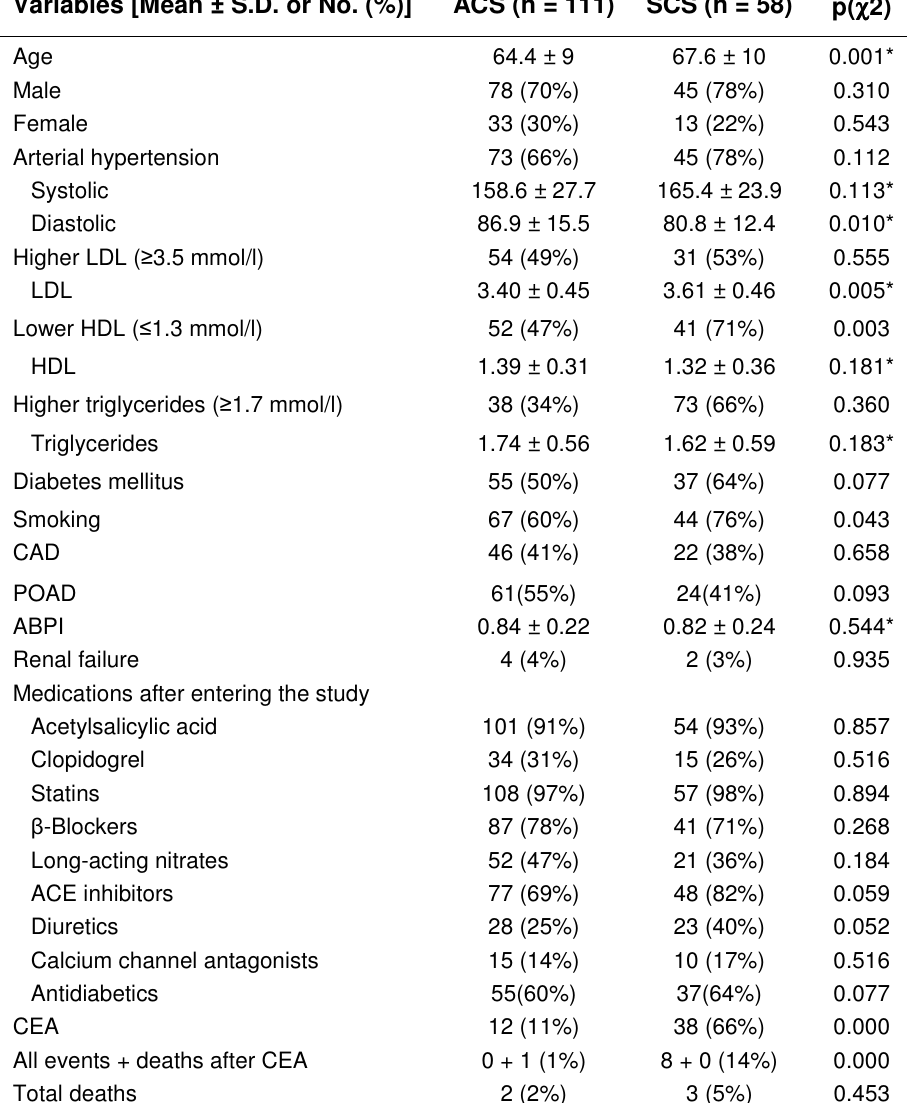
Demographics, Clinical Characteristics, and Risk Factors of ACS and SCS Groups Variables [Mean ± S.D. or No.